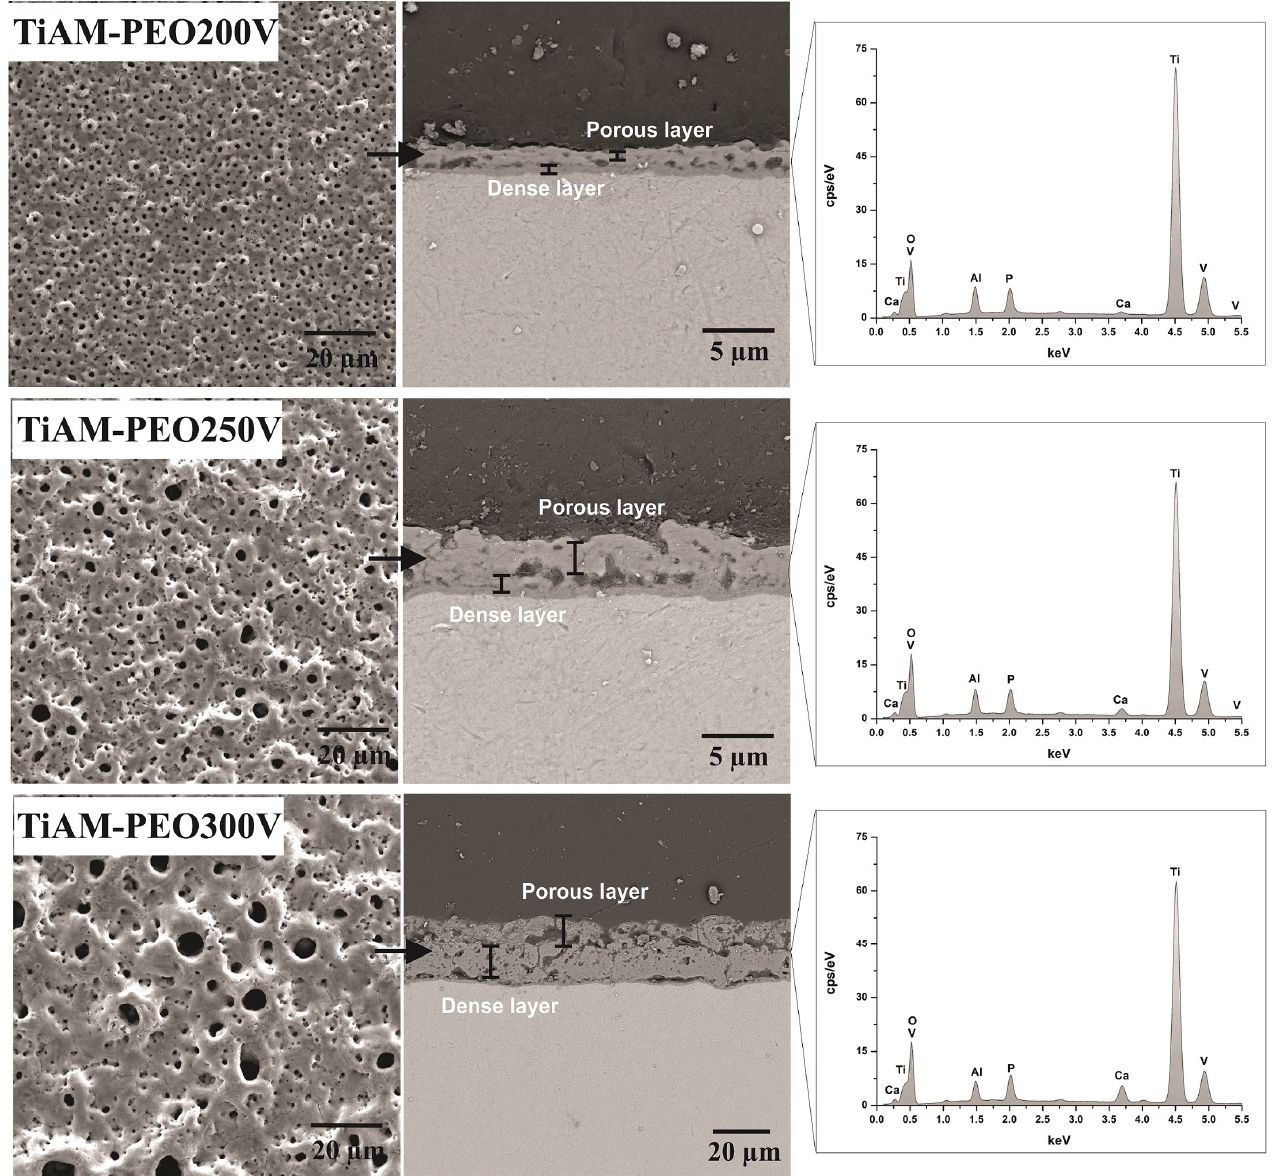
Figure 1. SEM/FEG images of top morphology, cross-sectional morphologies of the PEO coatings PEO on Ti-6Al-4V ELI alloy processed by L-PBF and surface EDS